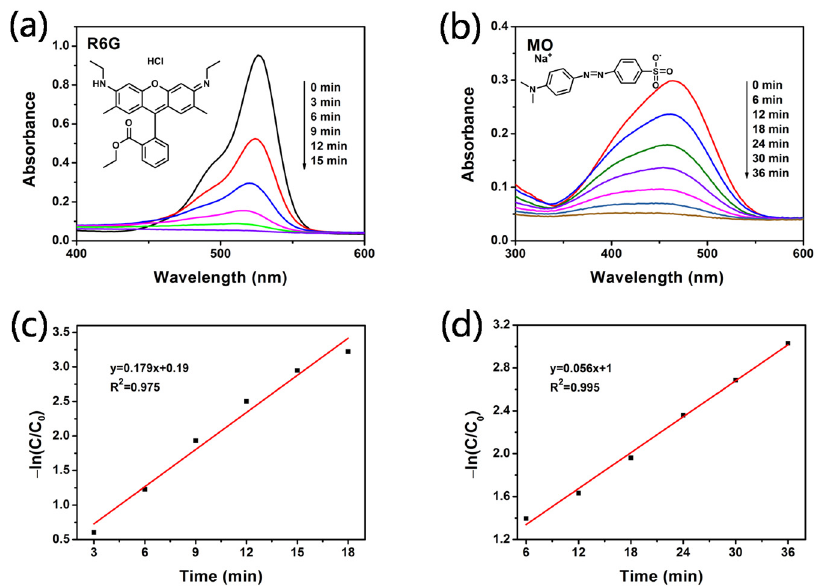
Figure 7. UV-vis absorption spectra of ( a ) R6G and ( b ) MO solution under UV irradiation for different times. Kinetic plots of − ln(C/C 0 ) versus time of ( c ) R6G and ( d )